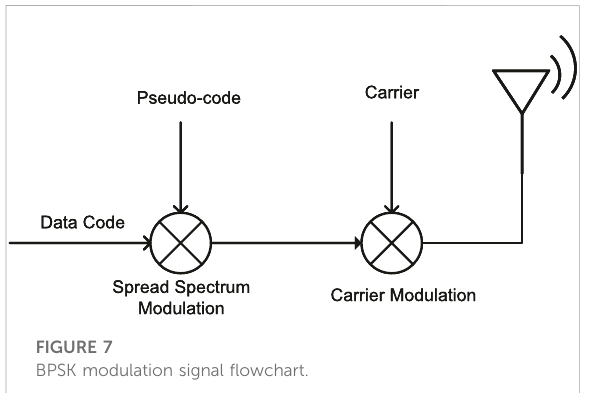
FIGURE 7 BPSK modulation signal fl owchart.